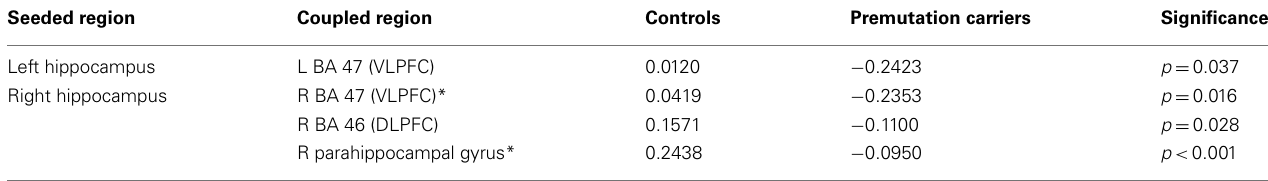
FIGURE 4 |Whole brain between group PPI analysis showing activation connectivity greater for controls than premutation carriers. The analysis was seeded in the left and right hippocampus (the seed